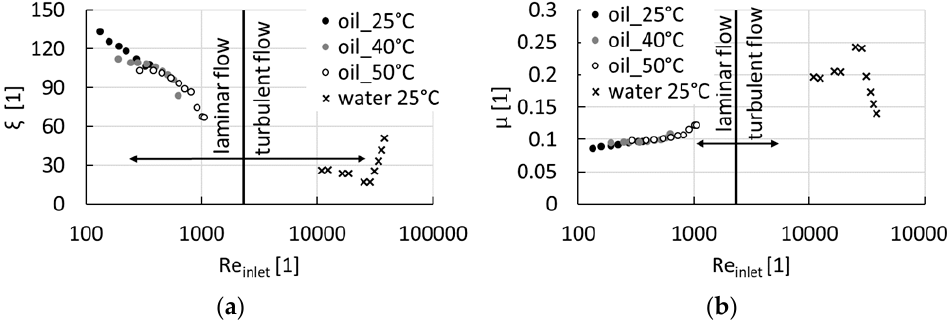
Figure 6. ( a ) Dependence of loss coefficient ξ (1) vs. Reynolds number at the inlet Re inlet (1); ( b ) Dependence of discharge coefficient µ (1) vs. Reynolds number at the inlet Re inlet (1). In Figure 6a, when oil flows in the laminar region, the loss coefficient is continuously decreasing except for flows where cavitation occurs. The loss coefficient for water varies significantly. For flows without cavitation, a decrease in the loss coefficient is noticeable, while the loss coefficient increases sharply with the increasing flow in the cavitation